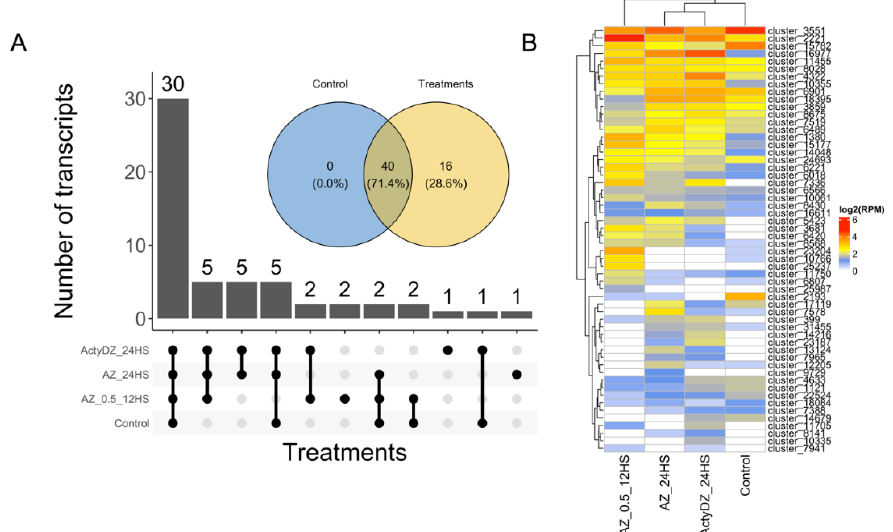
Figure 2. LTR retrotransposon-related transcripts (RTE transcripts) identified by ONT cDNA se- quencing. ( A ) Upset plot and Venn diagram showing the number of transcripts detected in different experimental conditions. ( B ) Heatmap of the expression (log2(RPM)) values of RTE transcripts in four experimental conditions: control (normal MS medium without heat stress), AZ_0.5_12HS (2 µ g/mL alpha-amanitin, 4 µ g/mL zebularin, 12 h of heat stress (37 ◦ C)), AZ_24HS (4 µ g/mL alpha-amanitin, 8 µ g/mL zebularine, 24 h of heat stress (37 ◦ C), ActyDZ_24HS (4 µ g/mL actinomycin D, 8 µ g/mL zebularine, 24 h of heat stress (37 ◦ C)).